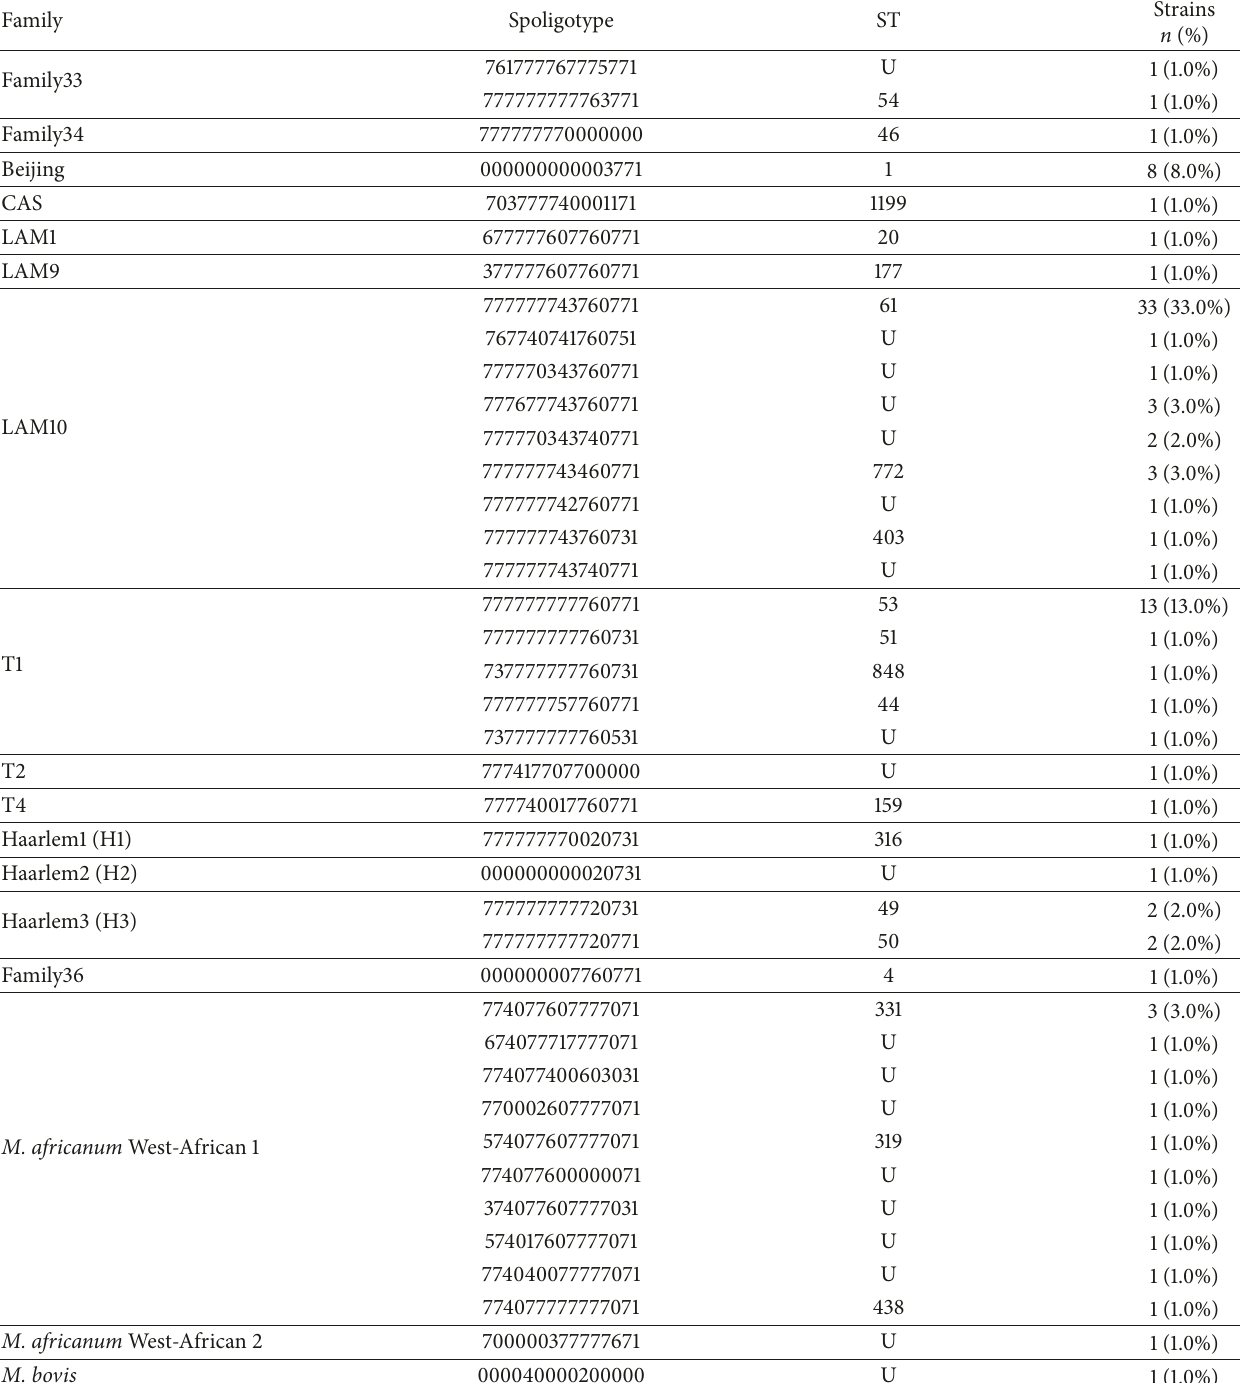
Table 3: Strains per